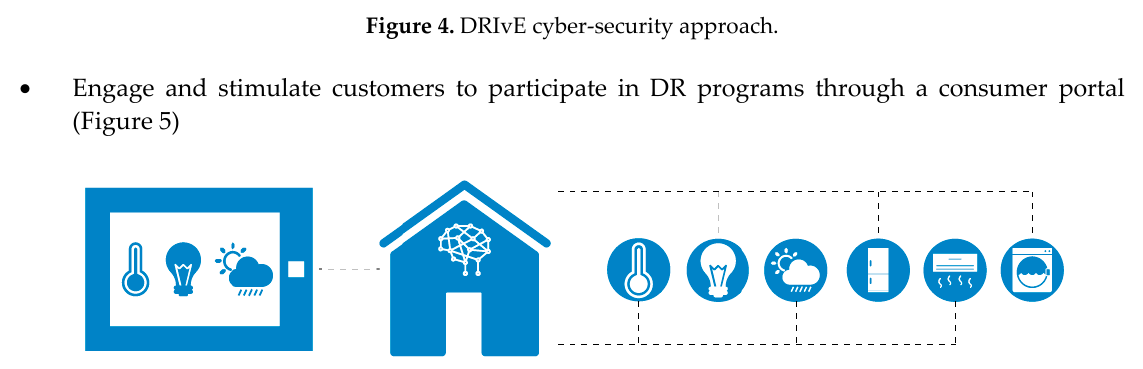
Figure 5. DRIvE consumer